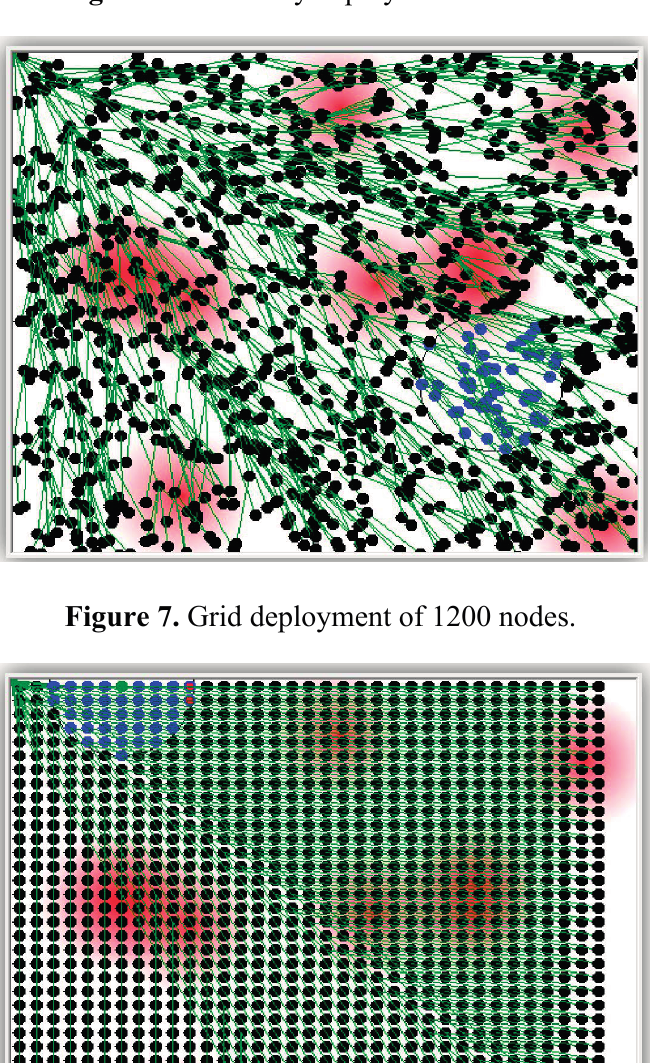
Figure 6. Randomly deployed 1200 nodes.